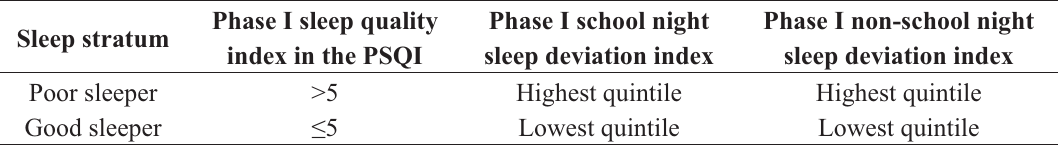
Table 1. Selection